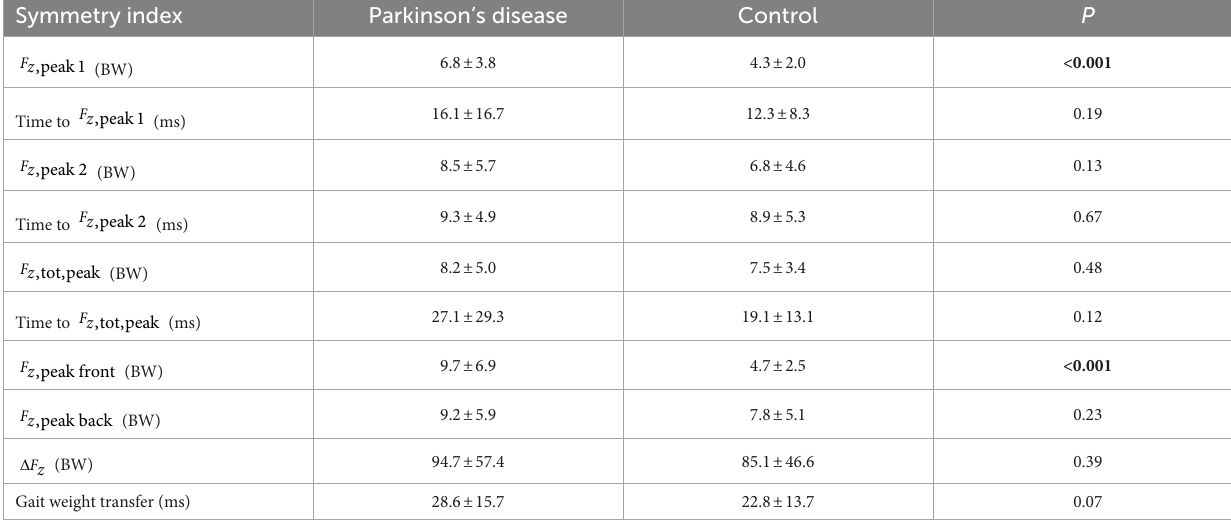
TABLE 5 Symmetry index of the force related variables for Parkinson’s disease and control